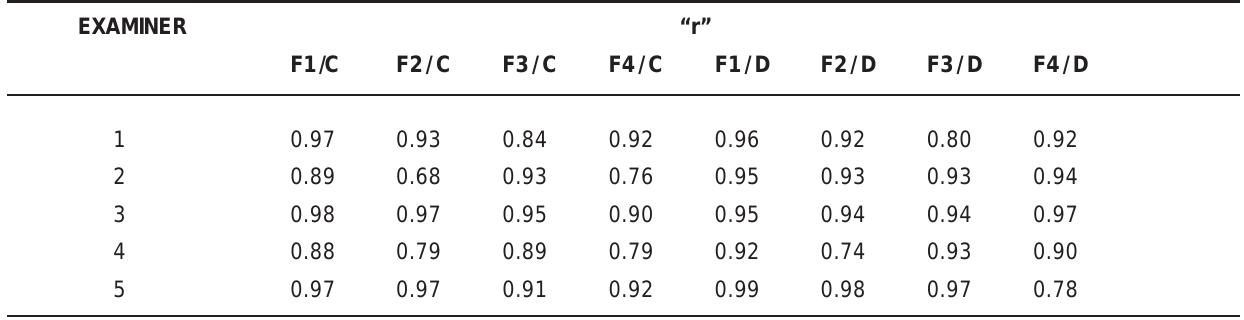
TABLE 2 - Intra-examiner evaluation at two different times (T between them (“r”)